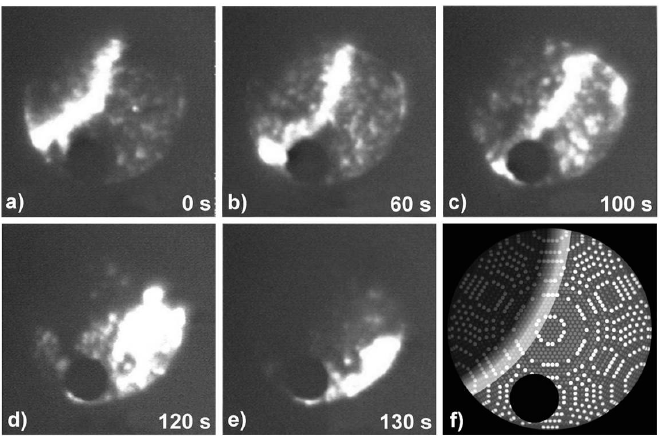
Figure 14. Imaging a chemical wave under reaction conditions by FIM: ( a – e ) Series of snapshots during the interaction CO/O 2 on an Au tip imaged by FIM during the ongoing process. A chemical wave is observed with its initiation at the apex part of the tip and propagation to the shank of the tip. The magnification in FIM corresponds to ~10 6 on a detector screen of 3 inches diameter. Conditions of acquisition: T = 300 K, P CO = 4 × 10 − 5 Pa, P O = 10 − 2 Pa, imaging field = 1.4 V/Å; ( f ) Guide to the eye of the wave superimposed with a ball model of the sample. The black region corresponds to the regions probed by mass spectrometry (see Figure 15). Reproduced from [196]. Copyright 2007, John Wiley & Sons, Ltd.